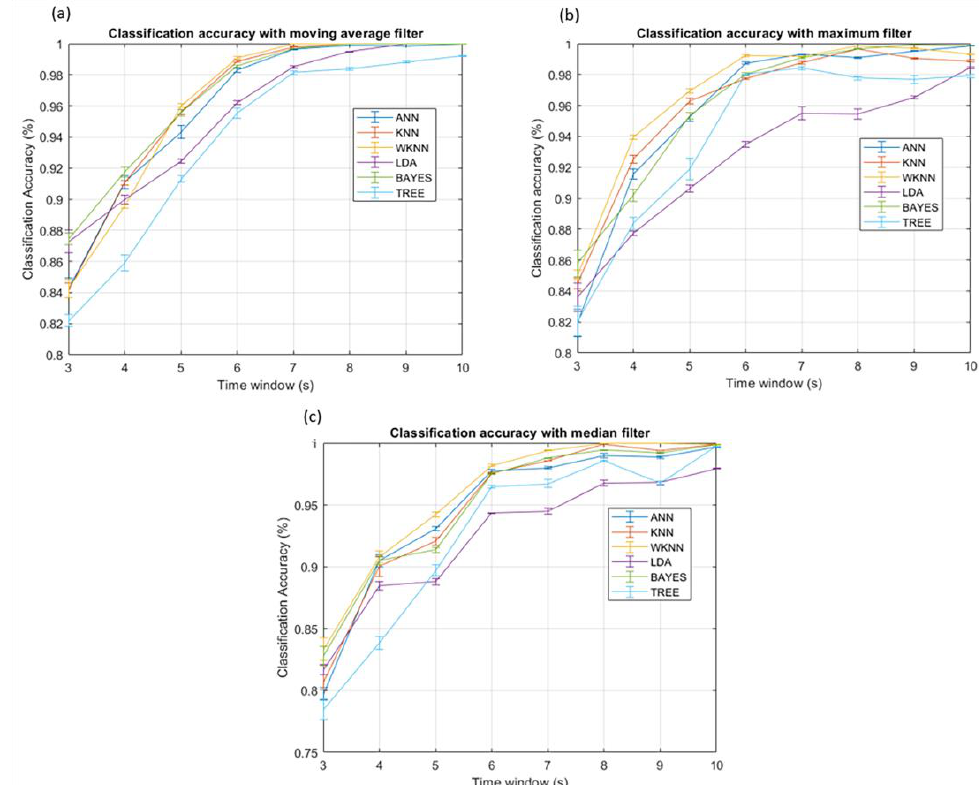
Figure 8. Classification performances of weighted k-NN, LDA-based classifier ( a ), ANN, and Tree Classifier ( b ) using a moving average filter.